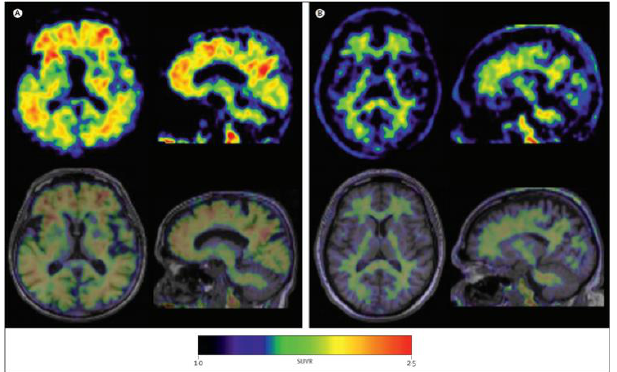
Figure 4. Axial and sagittal (18F)florbetaben brain PET images of an AD patient ( A ) and a healthy control ( B ) for the detection of Aβ [56]. The bottom row illustrates a fused PET/T1-weighted MRI image. Pet images were acquired 90–110 minutes post-injection. Images are reprinted with permission of the publisher [56].